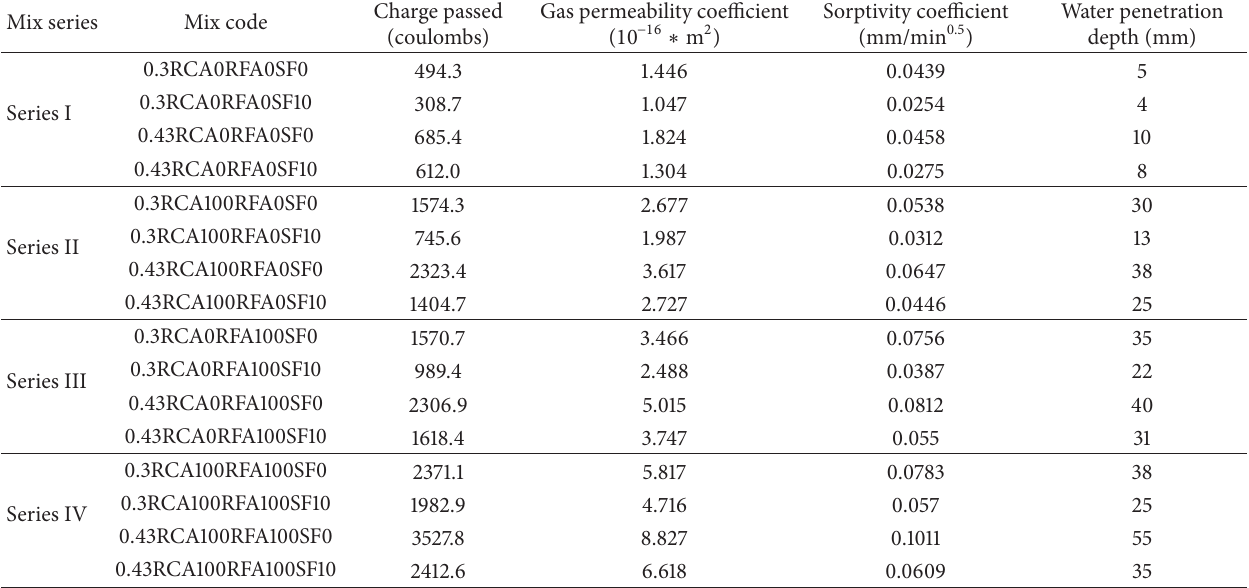
Table 5: Durability tests results of SCCs at 56